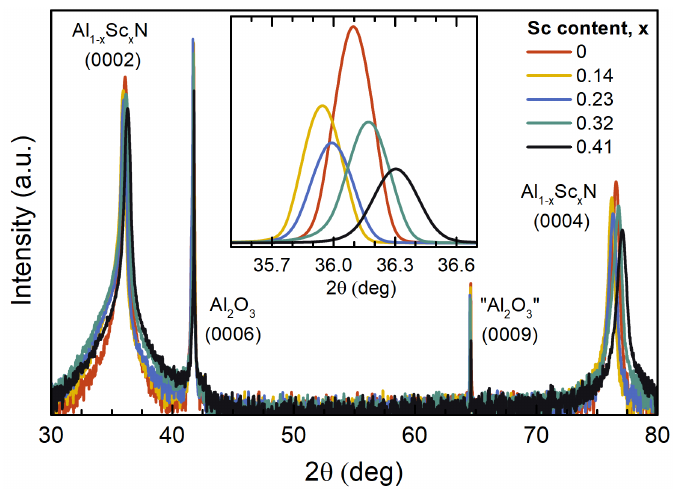
Figure 1. XRD symmetric θ /2 θ scans of AlScN films with various Sc amounts. Inset: the 2 θ range in the vicinity of the (0002) peak of the AlScN